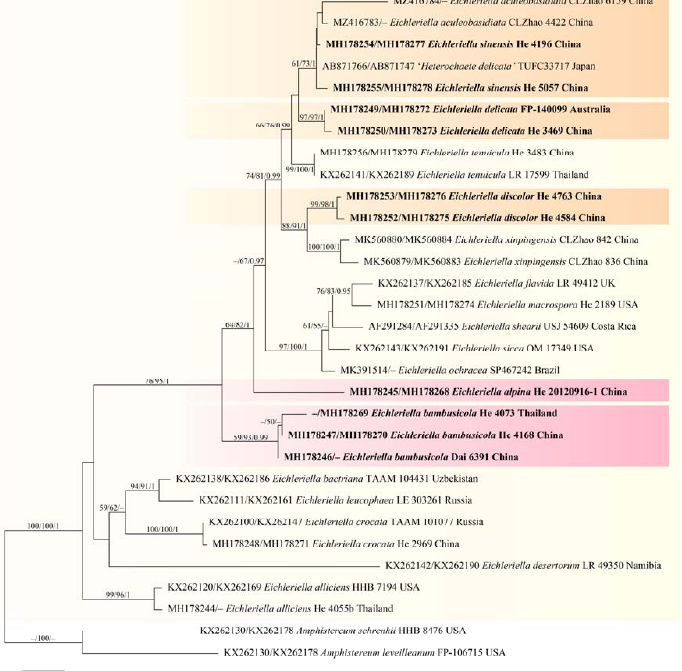
Figure 3. Phylogenetic tree of ML analysis from the concatenated ITS-28S sequences of Eichleriella species. Branches are labelled with parsimony bootstrap values ( ≥ 50%, first), likelihood bootstrap values ( ≥ 50%, second), and Bayesian posterior probabilities ( ≥ 0.95, third). New species (pink) and new combinations (orange) are highlighted and set in bold. In the Auriculariaceae tree (Figure 2), 19 distinct lineages corresponding to 18 known genera and the new genus, Heterocorticium , were recognized. Two new species of Hetero ‐ corticium , H. bambusicola and H. latisporum , formed a distinct lineage with strong support values (93/94/1). The lineages representing Eichleriella and Heteroradulum were strongly supported as monophyletic genera. In the Eichleriella tree (Figure 3), seventeen distinct lineages including two new species, E. alpina and E. bambusicola , and clades representing three Heterochaete species, H. delicata , H. discolor , H. sinensis , were recognized. Two samples of E. aculeobasidiata, including the holotype (CLZhao 6159) and one sample identified as Heterochaete delicata (TUFC33717), were nested within the E. sinensis lineage (61/73/1). In the Heteroradulum tree (Figure 4), eight lineages including the species, H. maolanense and